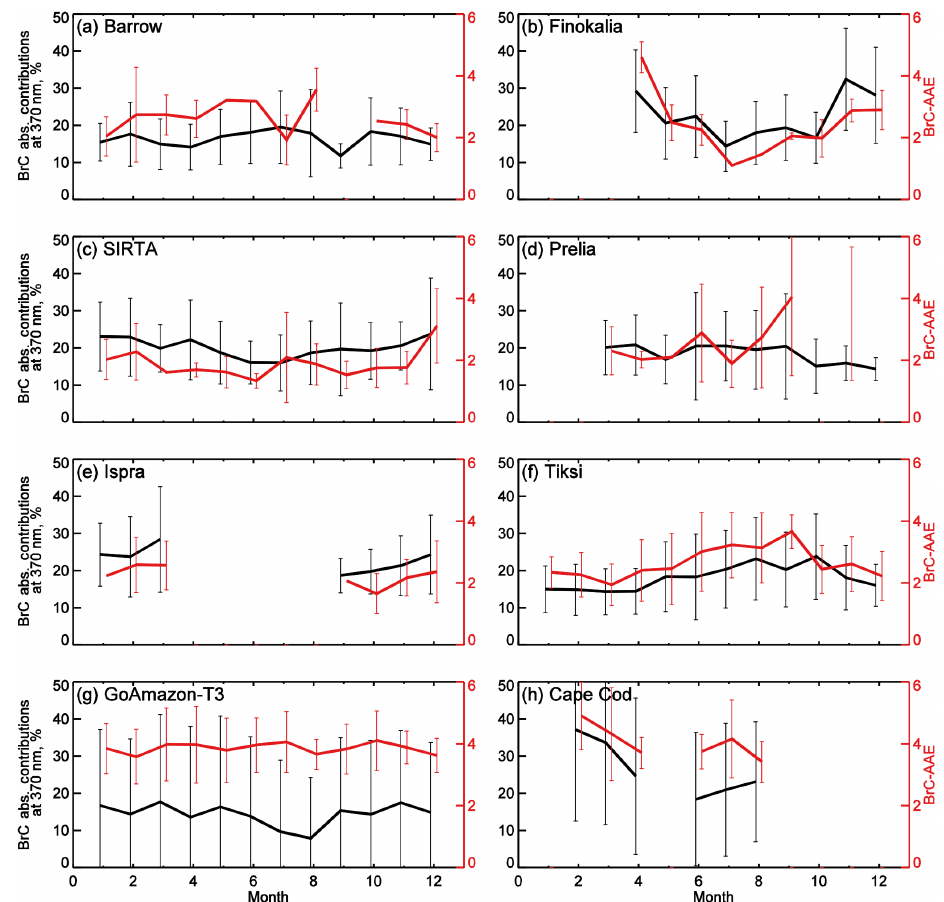
Figure 8. Monthly variation in the derived BrC contribution to total absorption at 370nm (black) and BrC-AAE (red) at a series of surface sites (see Table 1, Fig. 7). The BrC-AAE in (g) GoAmazon-T3 site and (h) Cape Cod is calculated using the 370–430nm wavelength pair, while that at other sites is based on the 370–470nm wavelength pair. Error bars indicate the standard deviation for values averaged in each